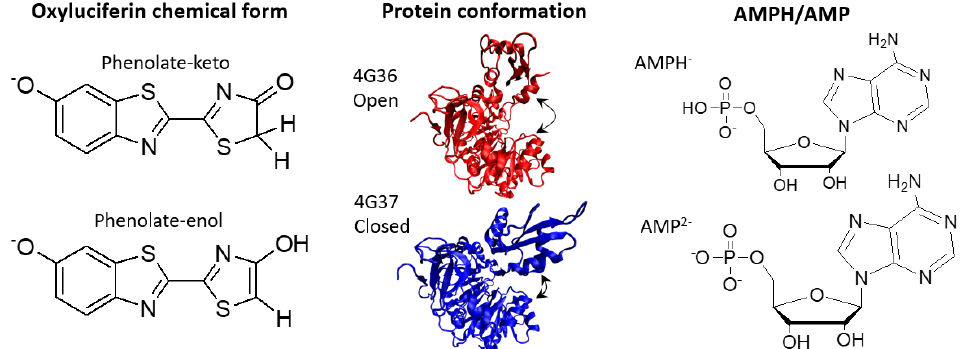
Figure 1. Representation of the oxyluciferin chemical forms, protein conformations and AMP protonation states considered in this study.